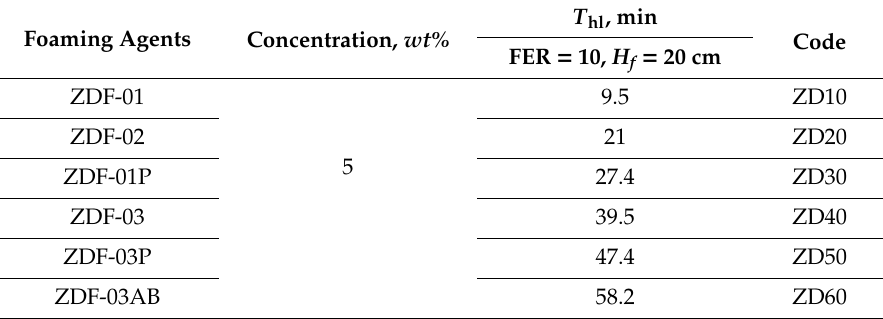
Figure 2. Device for testing the foam liquid half-life. Table 1. Liquid half-life for the different foaming agents.